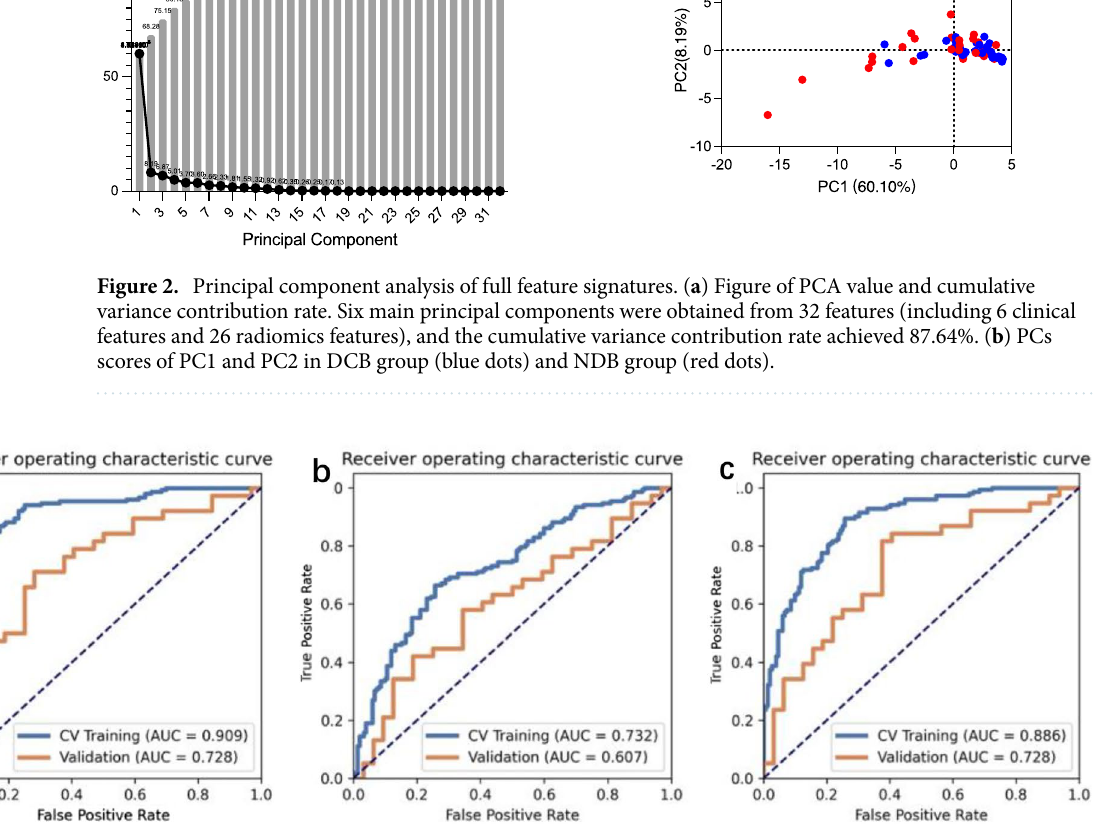
Figure 3. Receiver operating characteristic curves of ( a ) SVM, ( b ) LDA and ( c ) LR for predicting response to chemo-immunotherapy. CV cross validation, AUC area under the